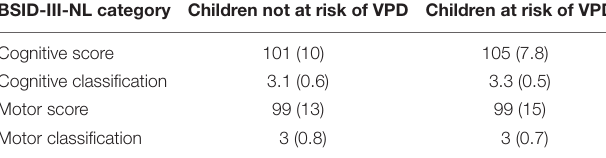
TABLE 8 | Results of the Bayley Scales of Infant Development (BSID-III-NL) assessment (average, SD), separately for the children not at risk of VPD and the children at risk of